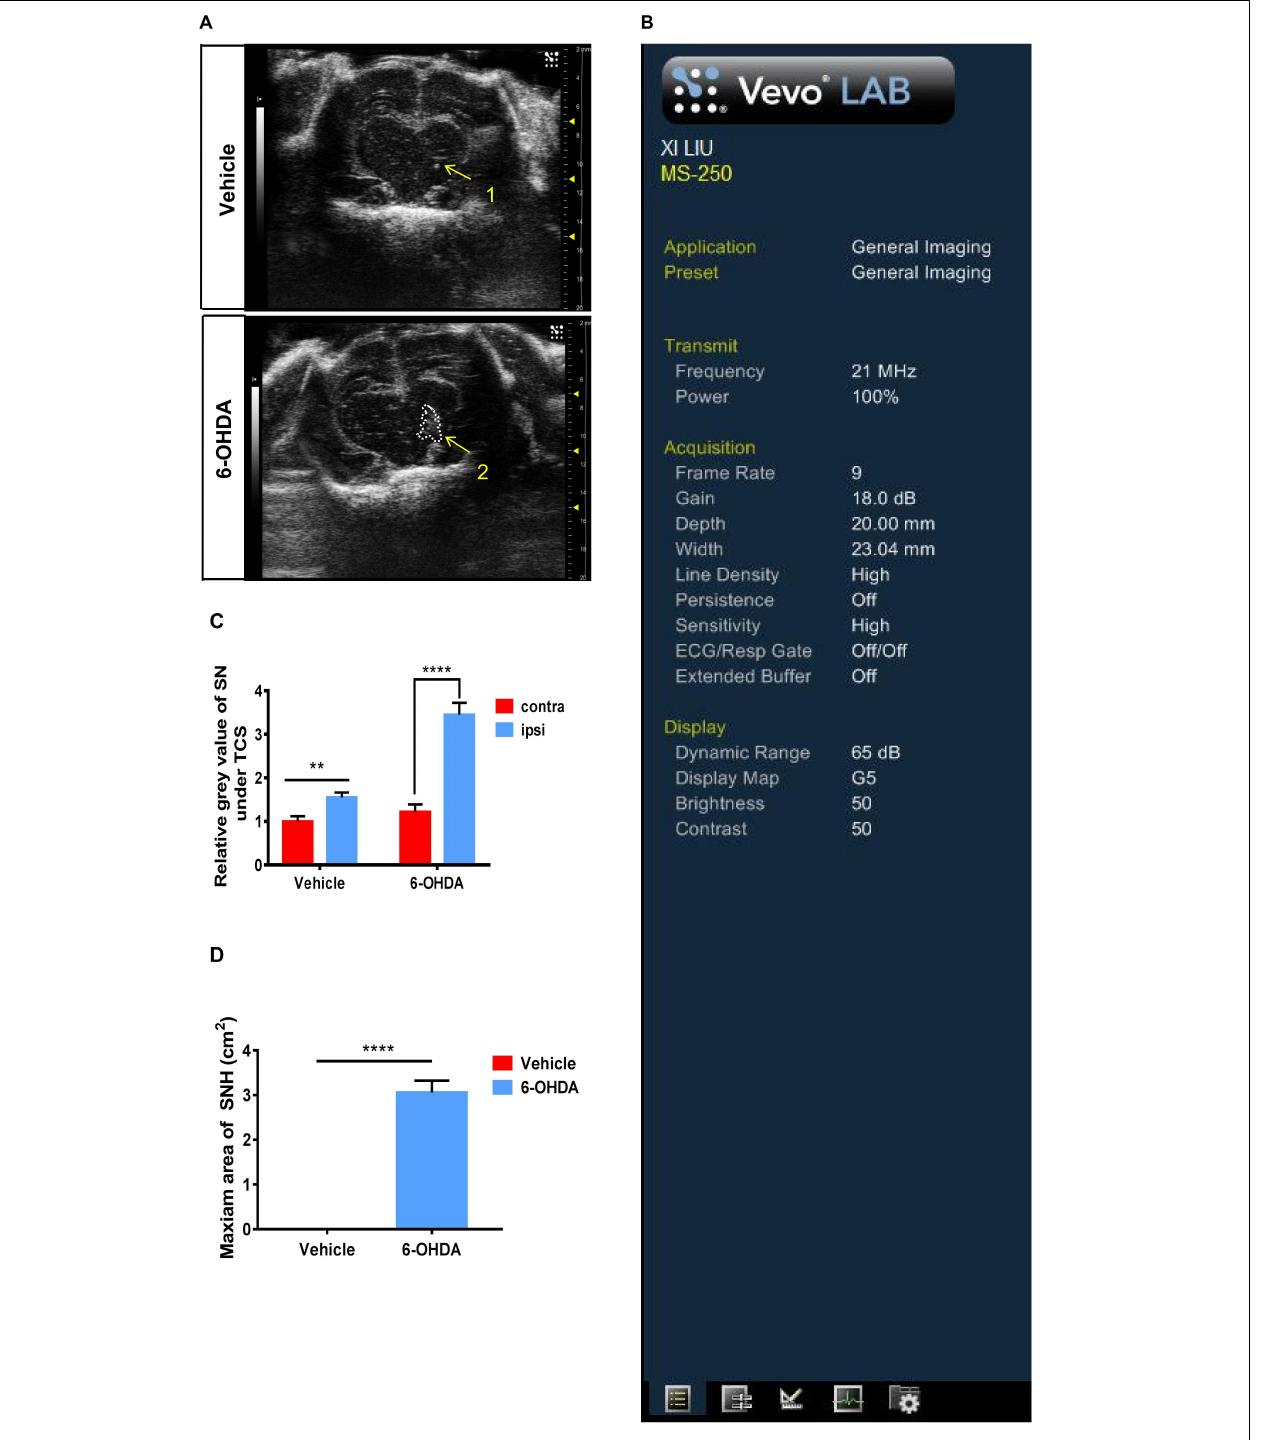
FIGURE 1 | Transcranial sonography (TCS) images and qualification of substantia nigra hyperechogenicity (SNH) after unilateral stereotactic surgery. Male rats were injected with either 6-hydroxydopamine (6-OHDA) ( n = 10) or vehicle ( n = 10). At 15 days after surgery, TCS detection was performed. (A) Image of the midbrain plane showing a significant hyperechogenicity of 6-OHDA-lesioned rats (2), while only a scatter echo corresponding to the shape of the needle was observed in the vehicle group (1). Area 2 = 3.057 cm 2 . (B) General condition of TCS detection. (C) Statistical result of the mean gray values of substantia nigra ( t -test). Vehicle group: P = 0.0015, t = 3.35, df = 50, F = 1.002. 6-OHDA group: P < 0.0001, t = 6.935, df = 52, F = 2.713. (D) Statistical result of the maximum SNH area ( t -test). P < 0.0001, t = 11.44, df = 12. *Comparison between contralateral and ipsilateral from a single group. ns P > 0.05, ** P < 0.01, *** P < 0.001, **** P < 0.0001.